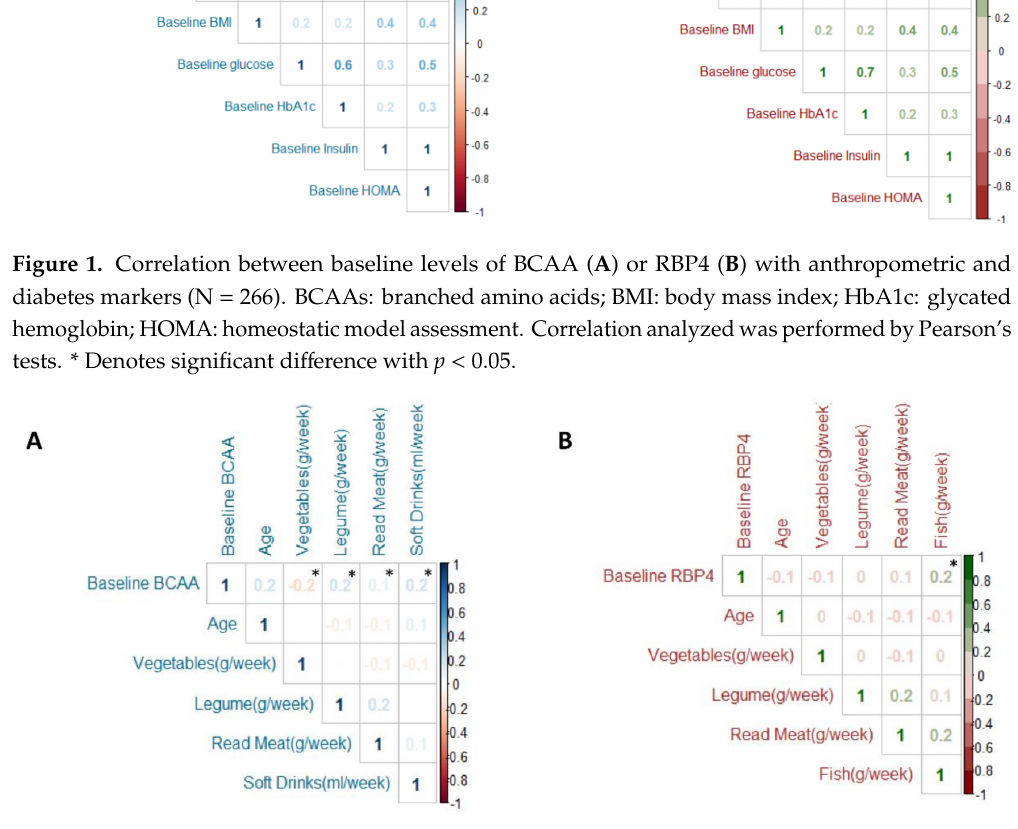
Figure 2. Correlation between baseline dietary items and baseline BCAA ( A ) or RBP4 ( B ) levels (N = 266). BCAA: branched amino acid. Correlation analyzed was performed by Pearson’s tests. * Denotes significant di ff erence with p <